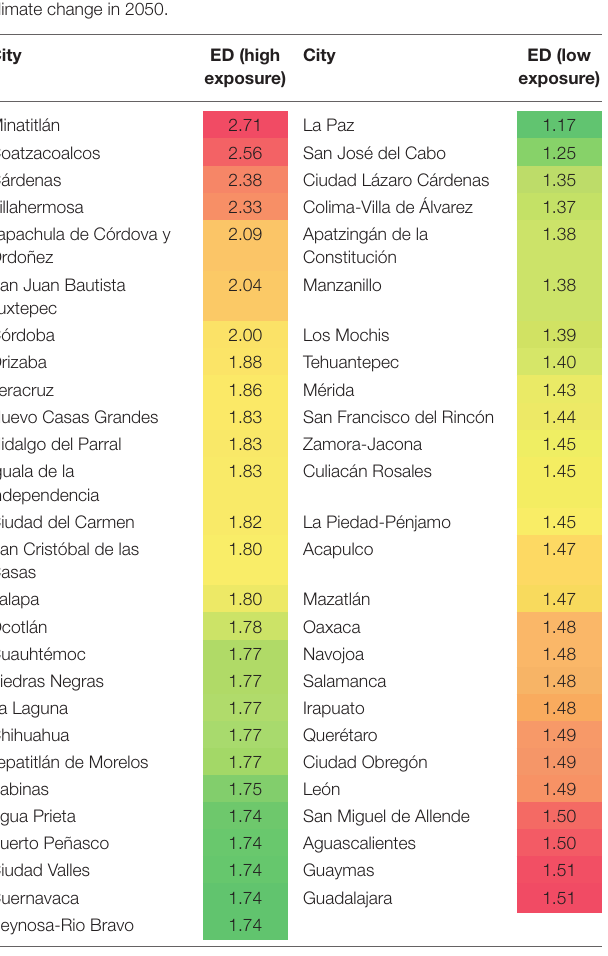
Colors from green to red denote lower to higher Euclidean distance